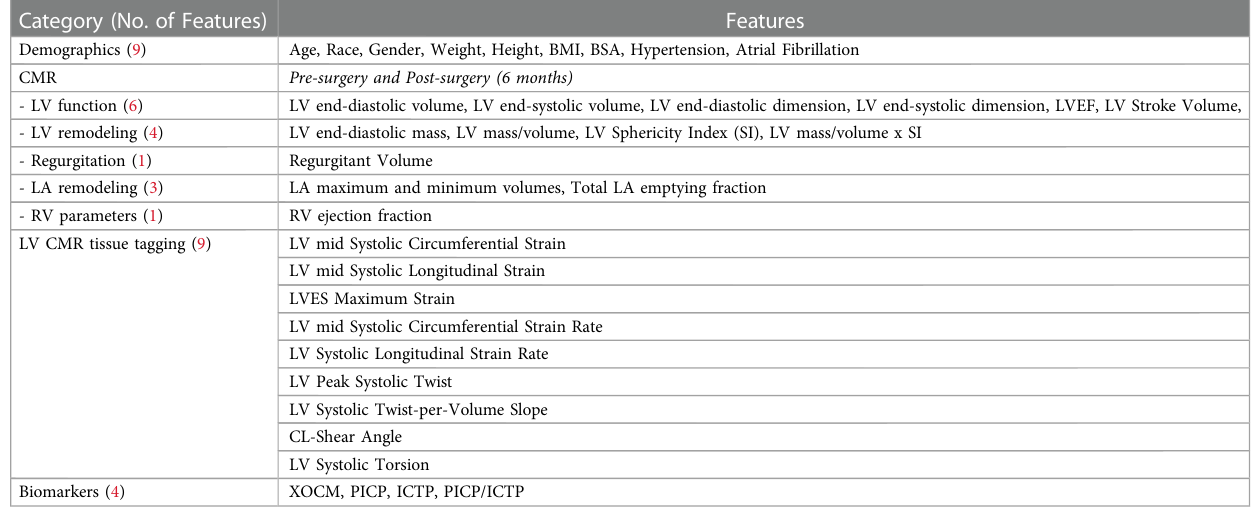
TABLE 1 Features included in predictive models ( N =37). Category (No. of